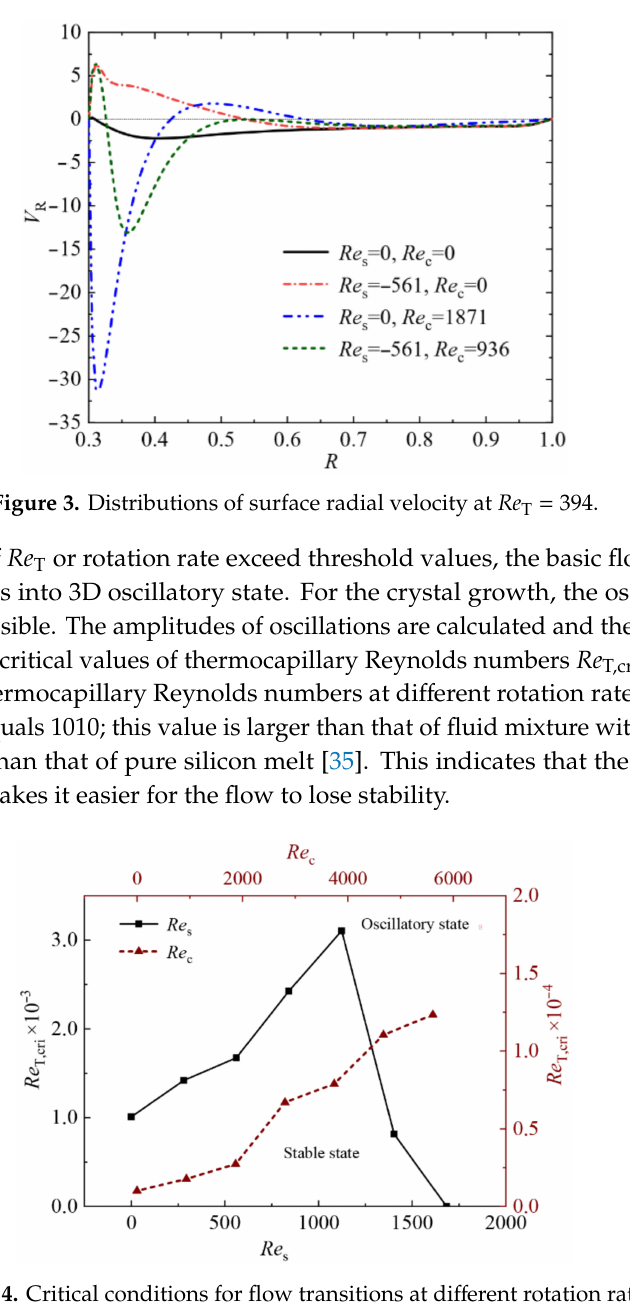
Figure 4. Critical conditions for flow transitions at di ff erent rotation